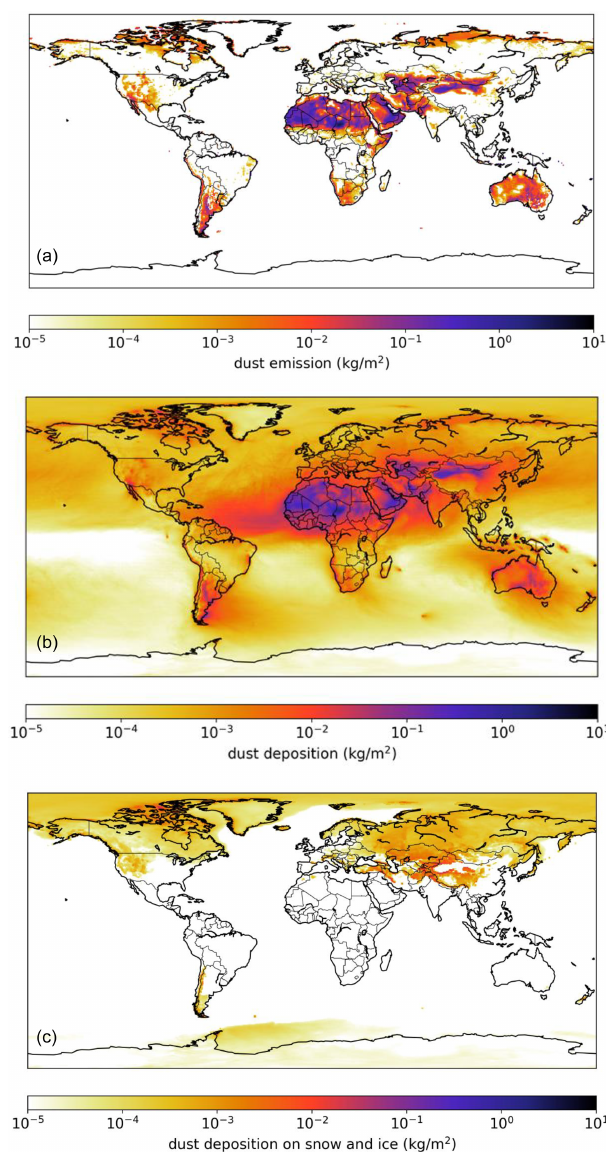
Figure 4. SILAM emission and deposition modeling results of dust emission (a) , dust deposition (b) , and dust deposition on snow and ice (c) (kg per m 2 ).